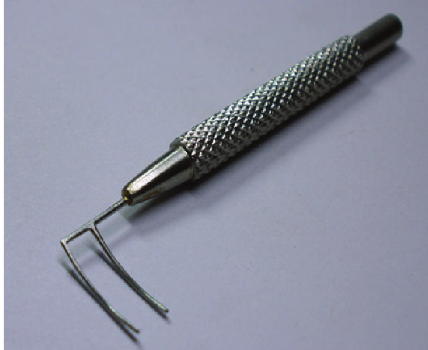
Figure 3: Harms trabeculotomy probe with double parallel prong